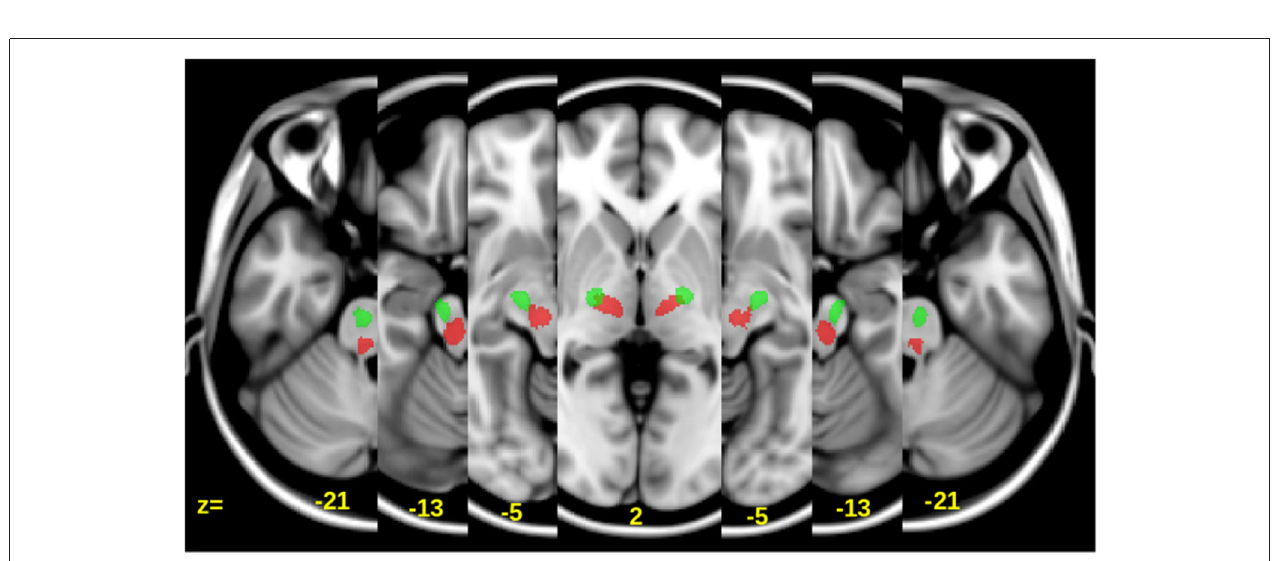
FIGURE 1 | Lesion density map of treated and untreated groups . Lighter blue indicates voxels with greater lesion overlap across patients.